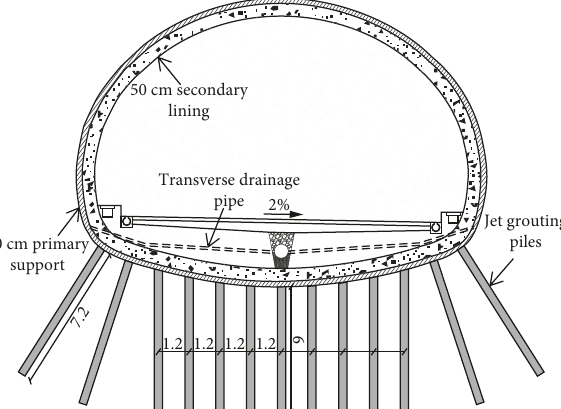
Figure 4: Design of the vertical jet grouting piles (m).